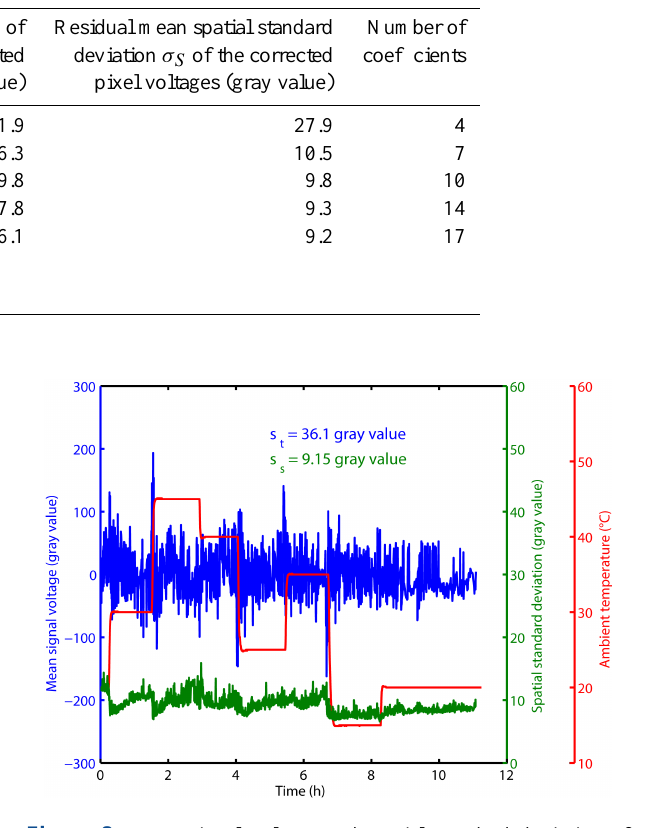
Figure 8. Mean signal voltage and spatial standard deviation of the entire sensor array after offset correction of the calibration data based on 17 correction coefficients. The mean value shows a con- stant level except for minor peaks when the ambient temperature changes. The spatial level changes slightly depending on the ambi- ent